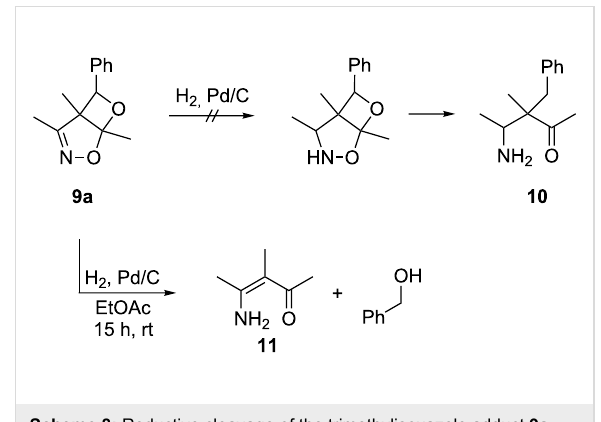
Scheme 8: Reductive cleavage of the trimethylisoxazole adduct 9a